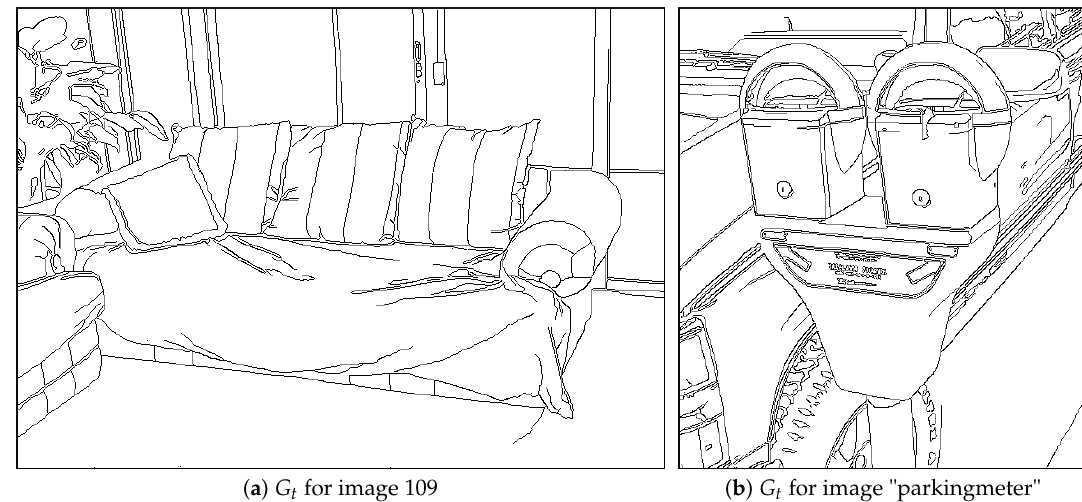
Figure 16. Ground truth edge images tied to original images available in Figure 17 used in the presented experiments. These G t images are available in